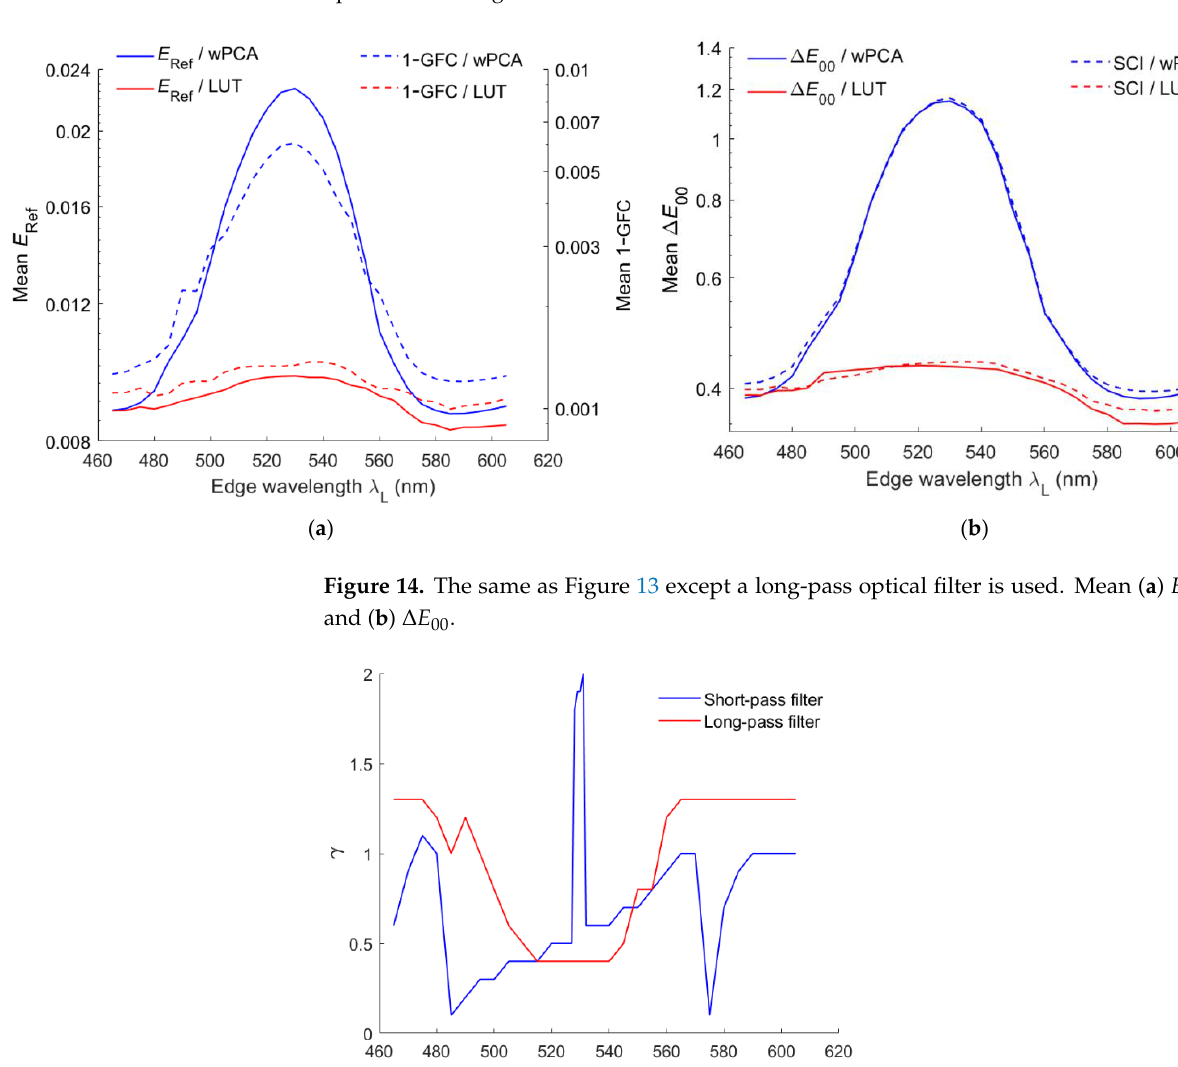
Figure 13. Mean ( a ) E Ref , 1 – GFC and ( b ) Δ E 00 , SCI versus the edge wavelength of the short-pass optical filter using the wPCA and LUT methods.